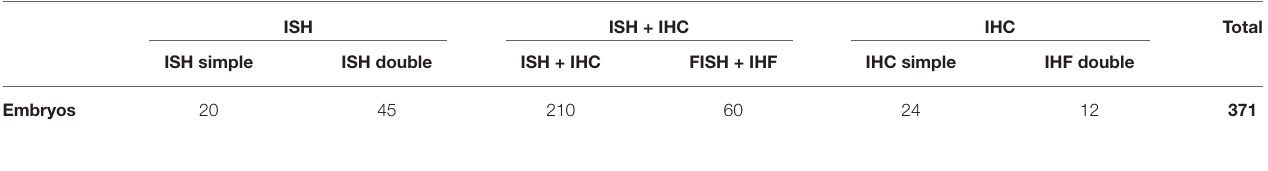
TABLE 1 | Number of animals used in each experimental approach.